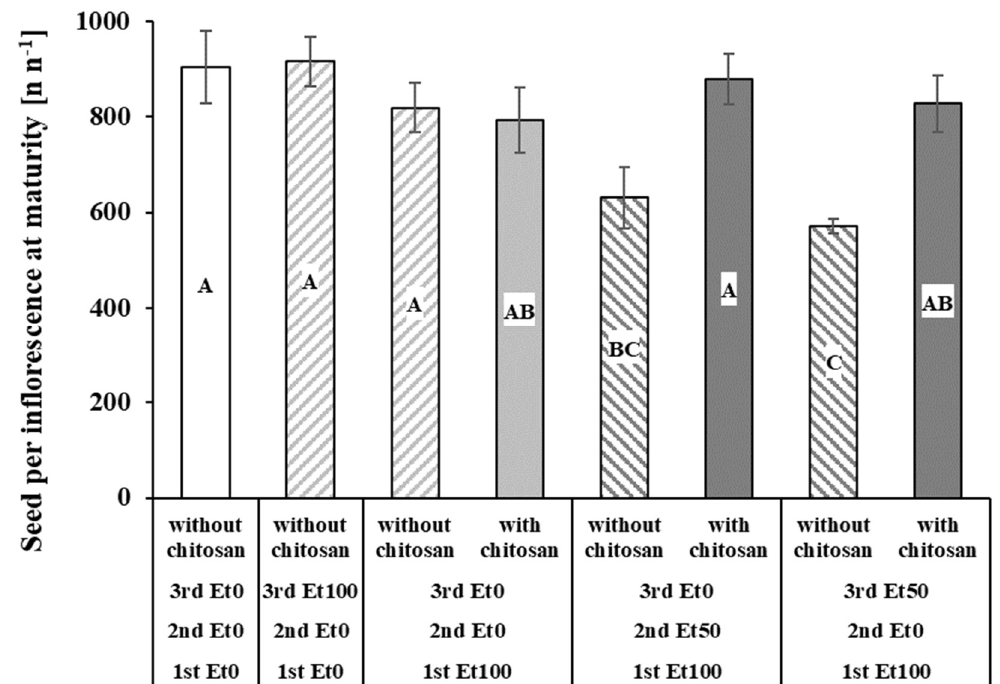
Figure 3. Role of the Ethylene [Et] application at full dose [100%, indicated as Et100] or half dose [50%], indicated as Et50 or no application [0%, indicated as Et0] during the first, second and third (1st, 2nd, and 3rd, respectively) occasion as shown in Figure 1) and chitosan application on the number of seeds per inflorescence of onion growing under rainfed conditions. Moment of ethylene application included an early, mid, and late applications indicated as first, second and third (1st, 2nd, and 3rd, respectively) occasions in the figures. Amount of ethylene application included 100% recommended rate (in the 1st or 3rd occasions) or 100% in the 1st + 50% in either the 2nd or 3rd occasions. Chitosan application was performed in ‘Treat” including a 100% application in the 1st occasion (irrespective of the further 50% application in the 2nd or 3rd occasions) compared to a non-chitosan treatment. A control with no chitosan and no ethylene was included. When Chit(Treat) showed a p < 0.05, p-differences of the LSmeans were computed and separated by a conservative Tukey − Kramer grouping at the 5%. Bars with a letter in common should not be considered different, according to Tukey − Kramer. Data are arithmetic means and standard errors ( n = 4).